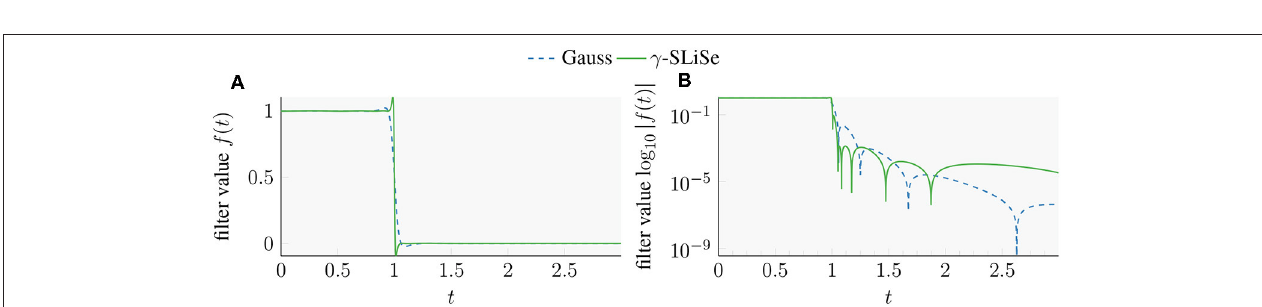
FIGURE 2 | Comparisons of the Gauss filter with our replacement candidate, γ -SLiSe, with p = 1.5 m on a test set of 2116 benchmark problems obtained from the “Si2” matrix. Both filters have 16 poles and are plotted in Figure 3 . (A) Number of FEAST iterations required by γ -SLiSe and the Gauss filter. (B) Performance profiles of convergence rates for γ - SLiSe and Gauss filters.